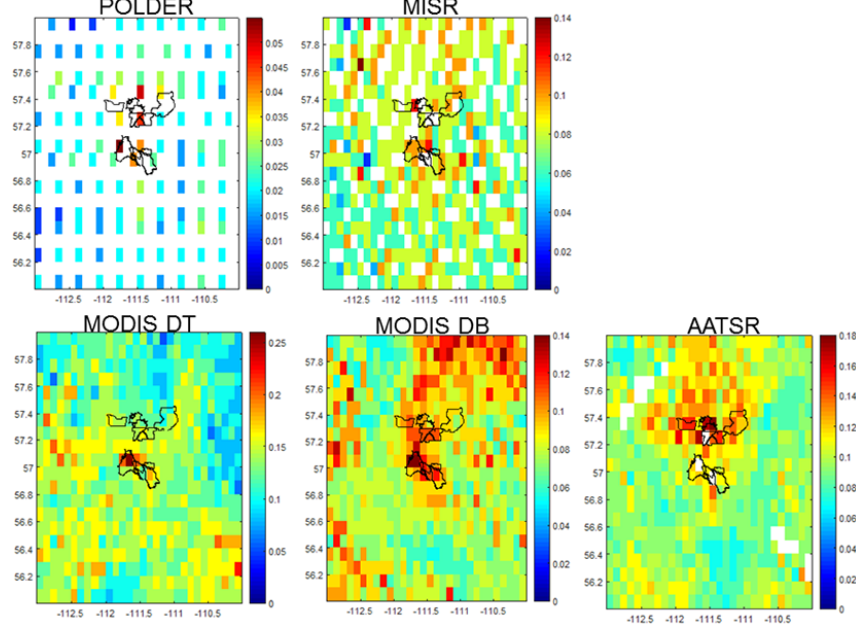
Figure 1. Climatological average AOD maps on a 0.1 ◦ × 0.1 ◦ latitude–longitude grid. Top left: POLDER 865nm (1996–2013). Note the gaps in time between the different members of the POLDER series in Table 1. Top right: MISR 558nm (2000–2015). Bottom left: MODIS Aqua DT using only confidence of 3 (2002–2015). Bottom centre: MODIS Aqua DB using only confidences of 2–3 (2002–2015) following Sayer et al. (2013). Bottom right: AATSR 550nm (2002–2012). Typical N is ∼ 65 for AATSR (see below), and white areas indicate N< 20. Black lines trace out the three surface mining areas in this and subsequent figures. Average coincident AERONET AOD at Fort McMurray is superimposed as a diamond with a black outline. In each panel, the AOD ranges from 0 to the greater of the maximum climatological mean satellite AOD or the Fort McMurray AERONET mean AOD, except for MISR, for which the AOD range is capped at 0.14 to not emphasize the anomalously high AOD at Moose Lake (57.6 ◦ N, 112.5 ◦